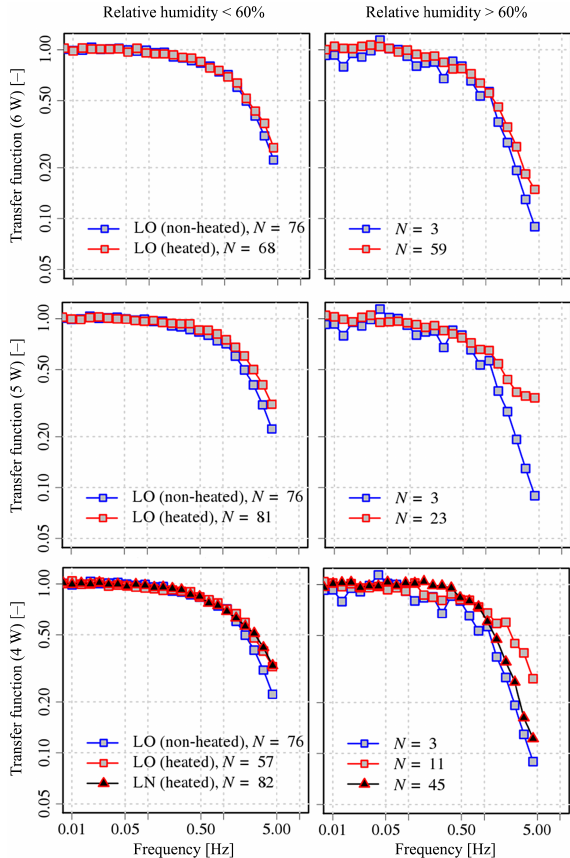
Figure 7. Ensemble transfer functions of LI-7200-measured H 2 O number density relative to LI-7500 for different heater settings of the intake tube and filter (rows) and ambient relative humidity classes (columns). Field results for the LI-COR old (LO) rain cap with and without heating of filter and intake tube are shown, as well as for the LI-COR new (LN) rain cap for the 4W heater setting, together with the respective ensemble sample size ( N ). Only half hours with sensible heat flux > 50Wm − 2 are used to homogenize the observations across different test